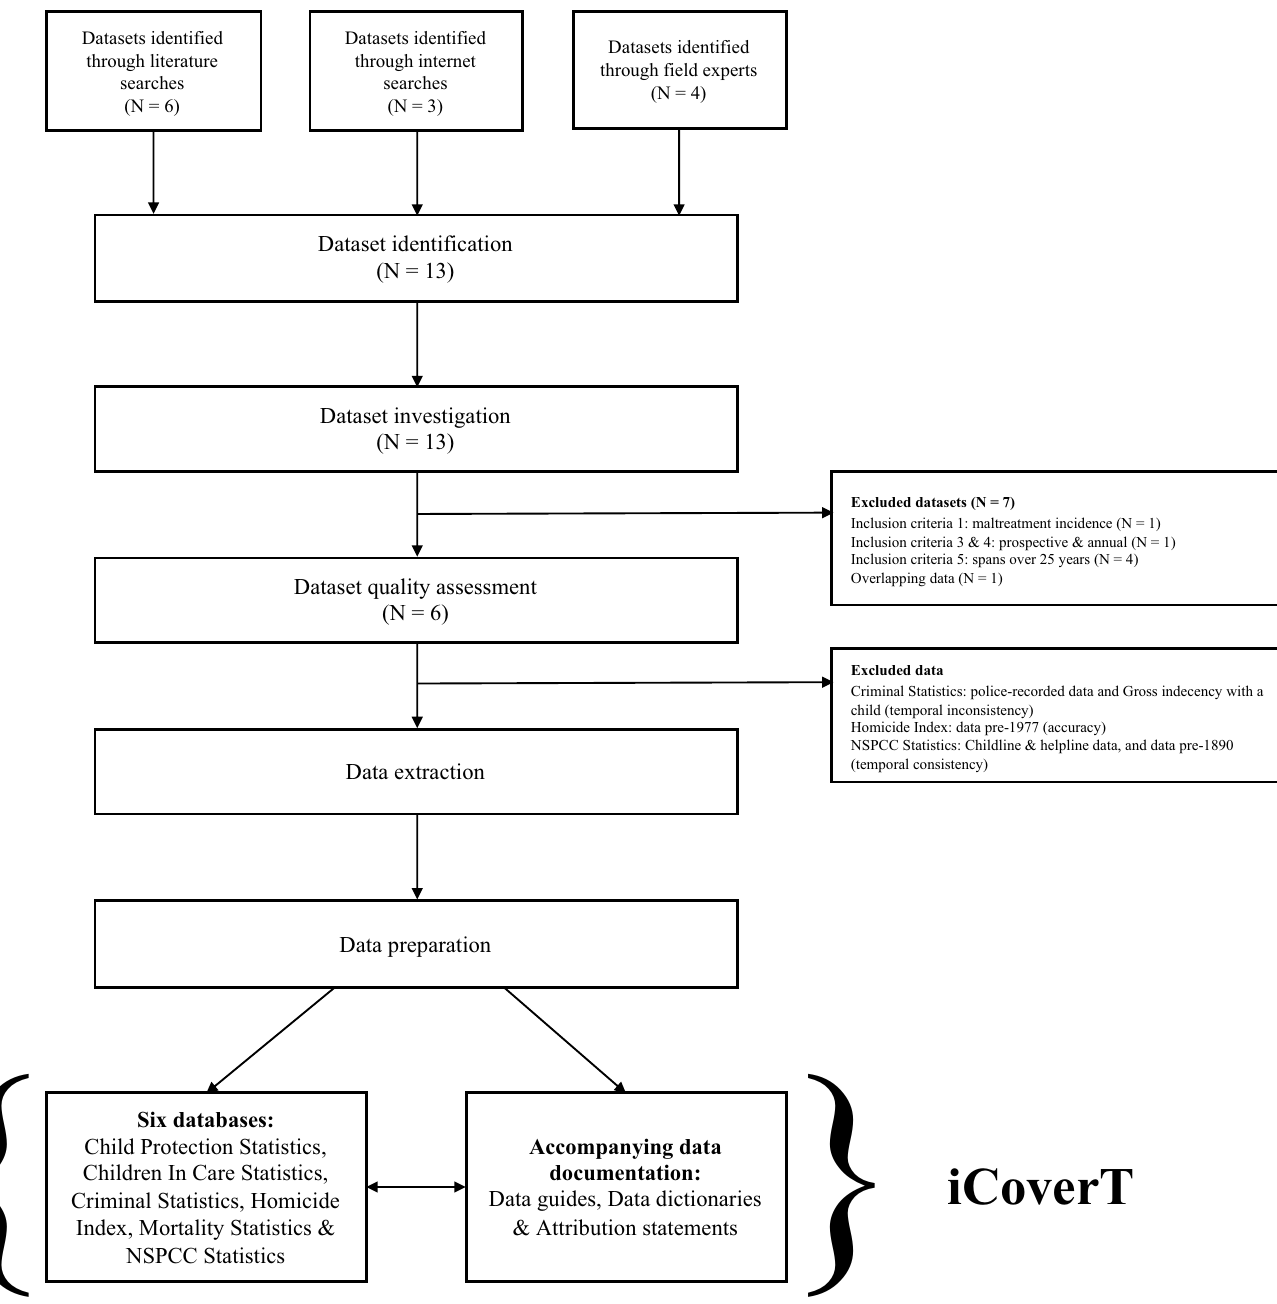
PLOS ONE | https://doi.org/10.1371/journal.pone.0201223 August 27,